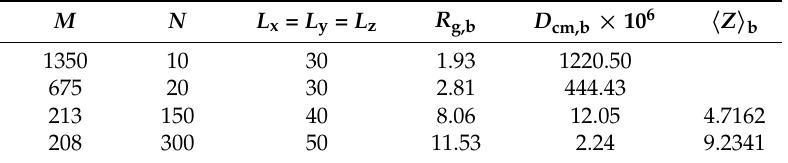
Table 3. Simulation details and results for unconstrained monodisperse polymer melts 1